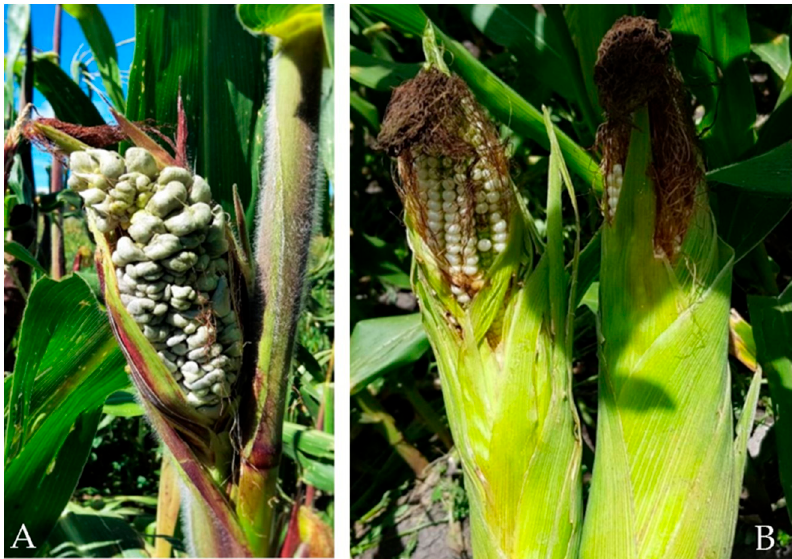
Figure 1. ( A ) Characteristic tumors of U. maydis with the white corn genotype; ( B ) control group with the Creole white genotype without the presence of tumors.